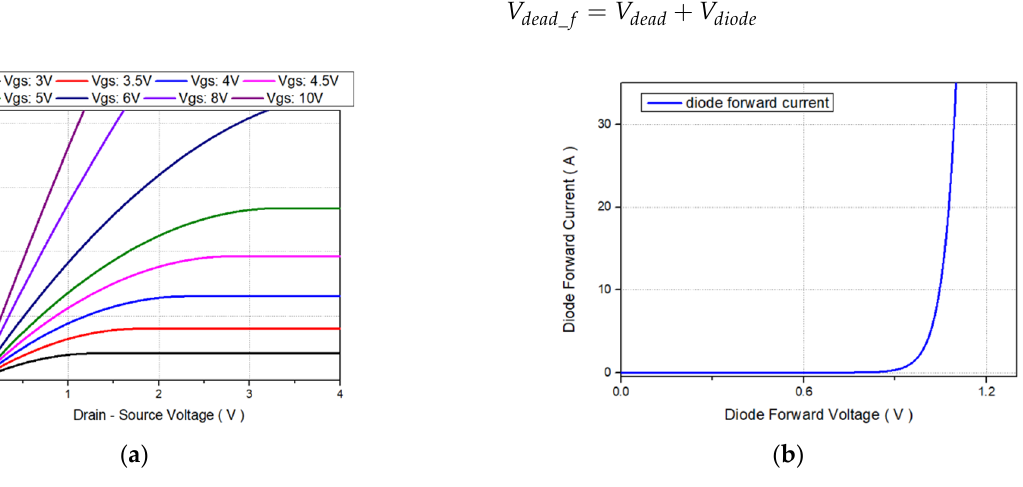
Figure 8. ( a ) Turn-on characteristics of the MOSFET ( b ) Turn-on characteristics of the diode.